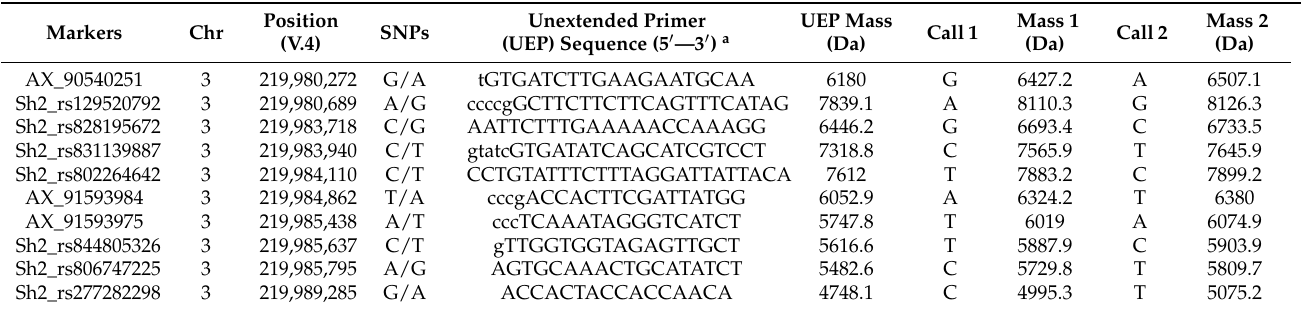
Table 2. Details of SNP markers for Sh2 gene used for genotyping by MassARRAY ® platform.